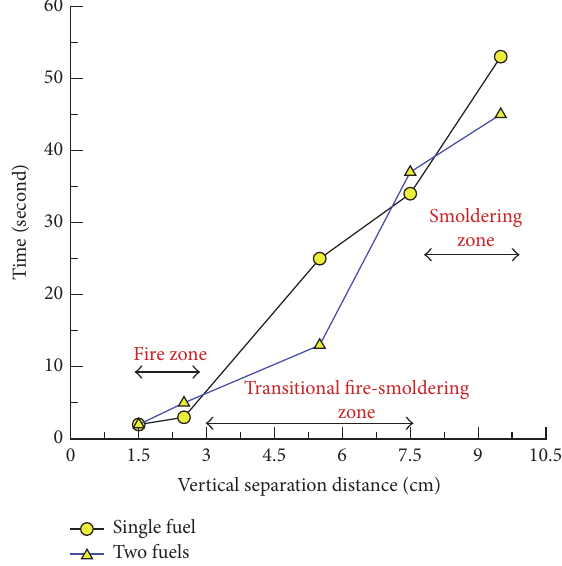
Figure 10: Effect of buoyant convection on transitional smoldering.